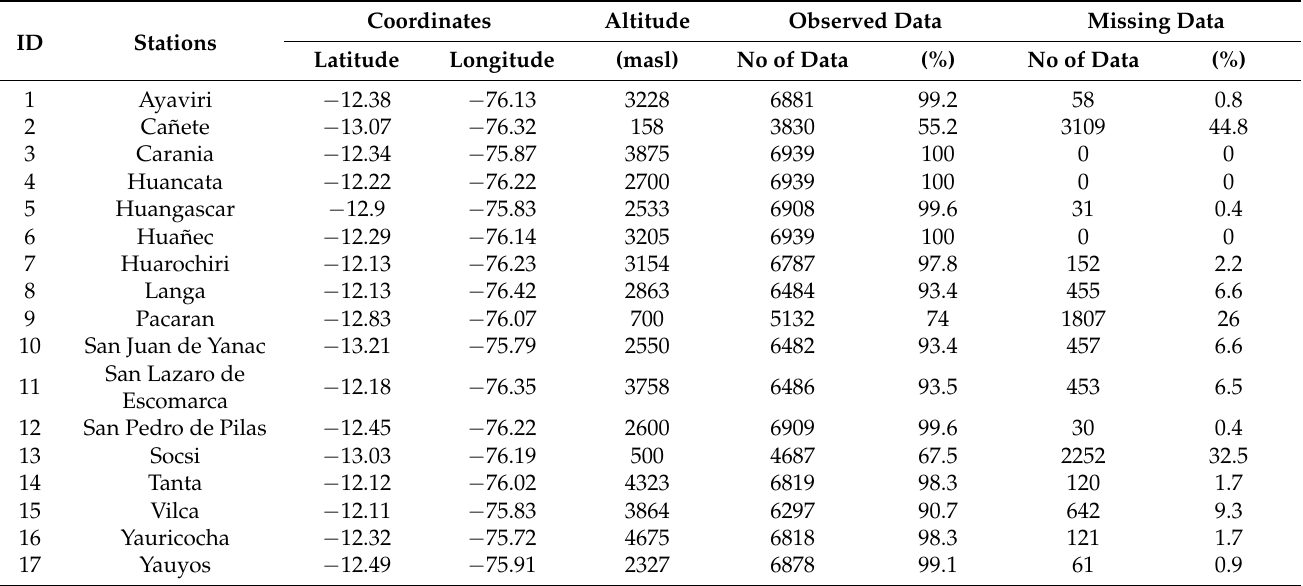
Table 1. Rainfall stations of MOC watersheds, 2001–2019